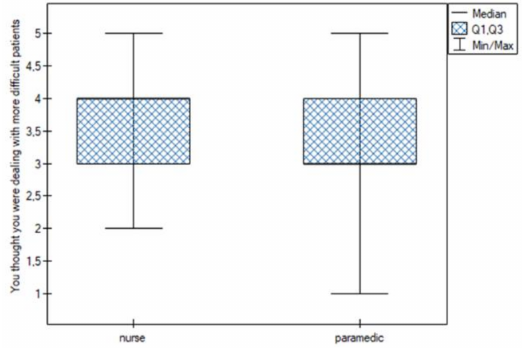
Figure 3. Working under pressure.